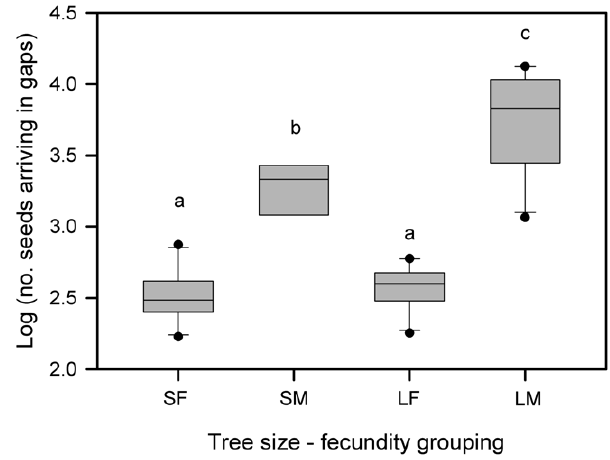
Figure 4. The ratio of live mahogany ( Swieteniamacrophylla ) juveniles to dispersed seeds downwind of 25 parent trees in Para´, Brazil. A Loess smoother line was fit to guard against diminished precision with increasing distance in 5-m intervals (see Methods for details). Data shown are limited to , 70 m distance because of very low number of seeds and high degree of imprecision at distances thereafter.